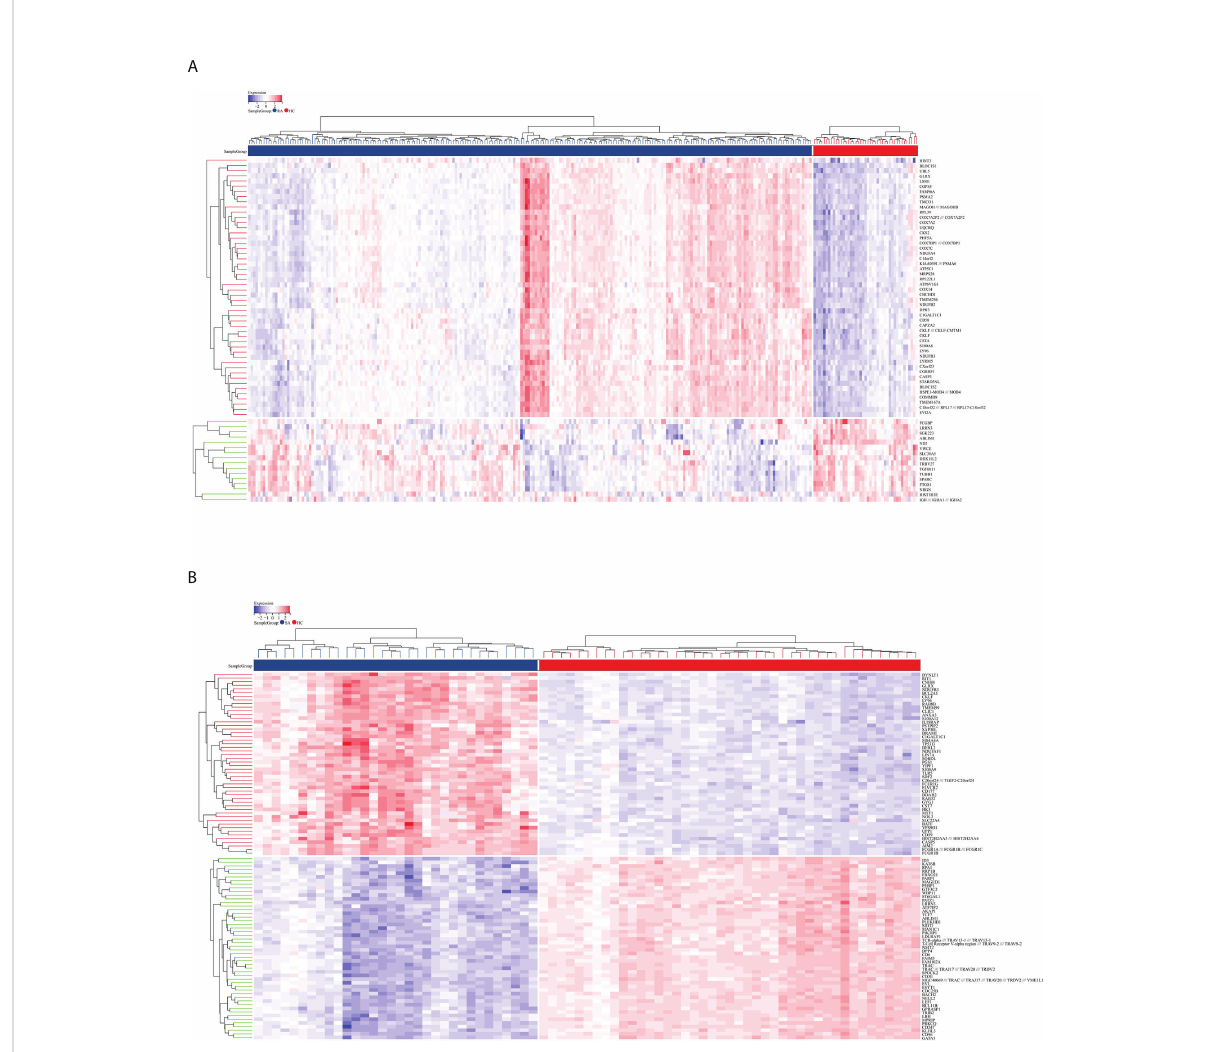
FIGURE 3 DEG distribution. (A) The clustering heat map shows the DEGs in the GSE93272 dataset. The RA group ’ s samples are colored blue, whereas the HC group ’ s samples are colored red. Red rectangles indicate elevated genes ( P < 0.05), whereas blue rectangles indicate downregulated genes ( P < 0.05). (B) The clustering heat map shows the intersection of DEGs in the GSE33341 dataset. The SA group ’ s samples are colored blue, whereas the HC group ’ s samples are colored red. Red rectangles indicate elevated genes ( P < 0.05), whereas blue rectangles indicate downregulated genes ( P <